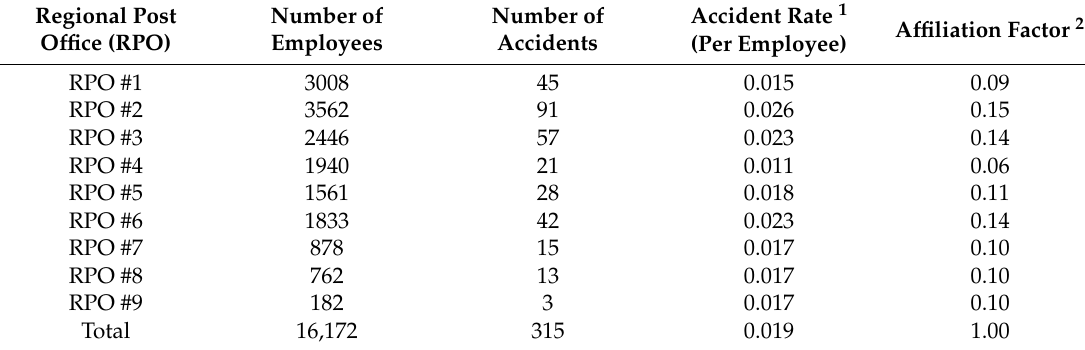
Table 3. Affiliation